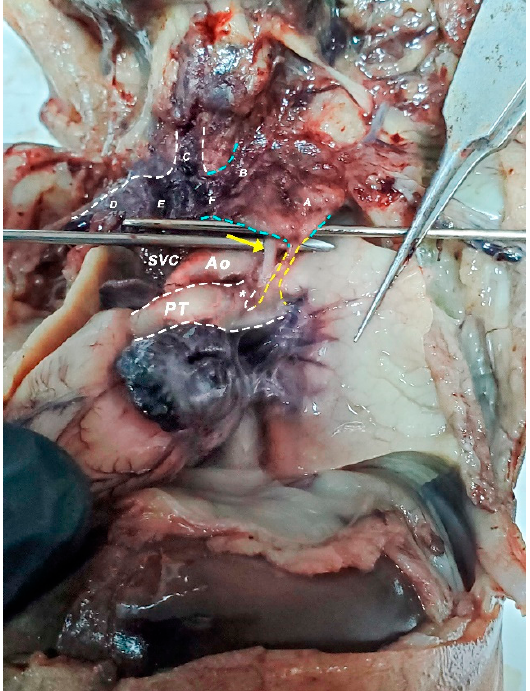
Figure 9. Heart, mediastinal vessels, oblic-left view; heart was pulled towards the right in order to draw attention to the arteriovenous anastomosis. Yellow dashed lines highlight the anastomosis between the left pulmonary artery and left brachiocephalic trunk. Blue dashed lines outline the contour of the enlarged left brachiocephalic trunk. A—left subclavian vein; B—left internal jugular vein; C—right internal jugular vein; D—right subclavian artery; E—right brachiocephalic trunk; F—left brachiocephalic trunk. SVC—superior vena cava; Ao—aorta/aortic arch; PT—Pulmonary trunk; Yellow arrow—vagus nerve.